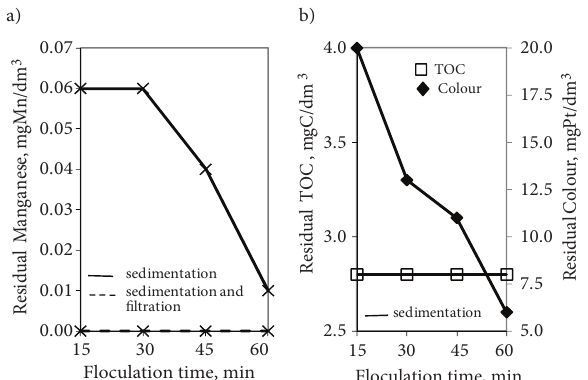
Figure 7. Effect of the type of alkalizing reagent: Ca(OH) 2 or NaOH on the amount of iron and turbidity (a) and colour (b) removed from the water in the sedimentation